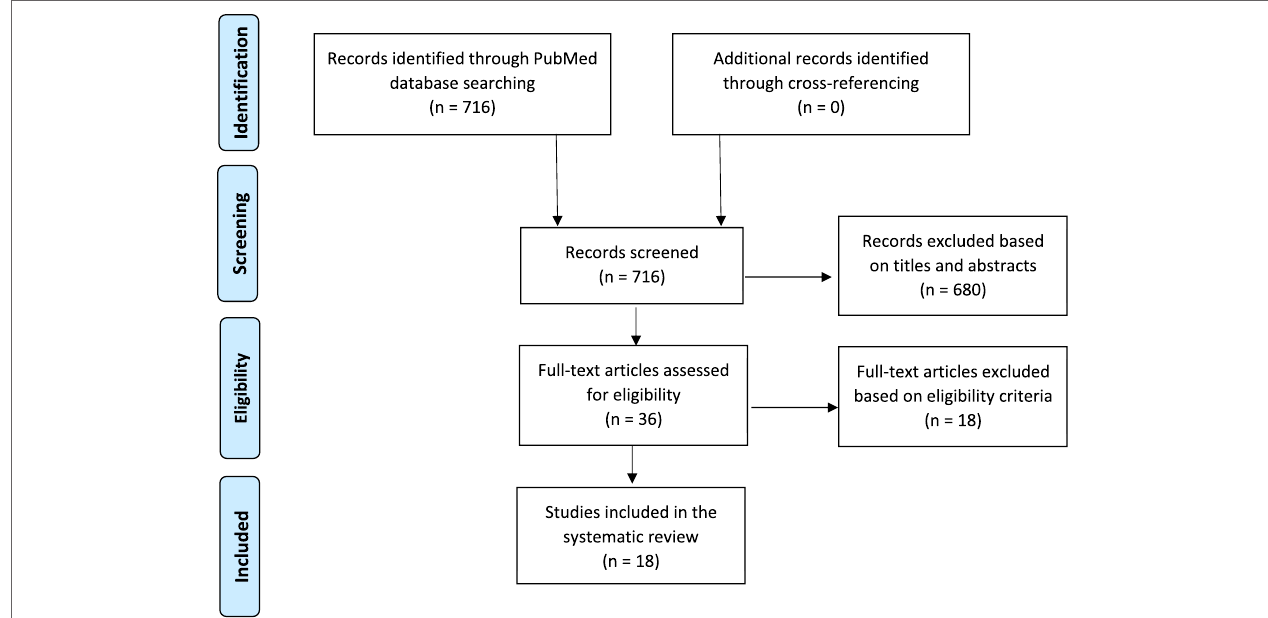
FiGURe 1 | PRISMA flow chart: the process of selecting relevant